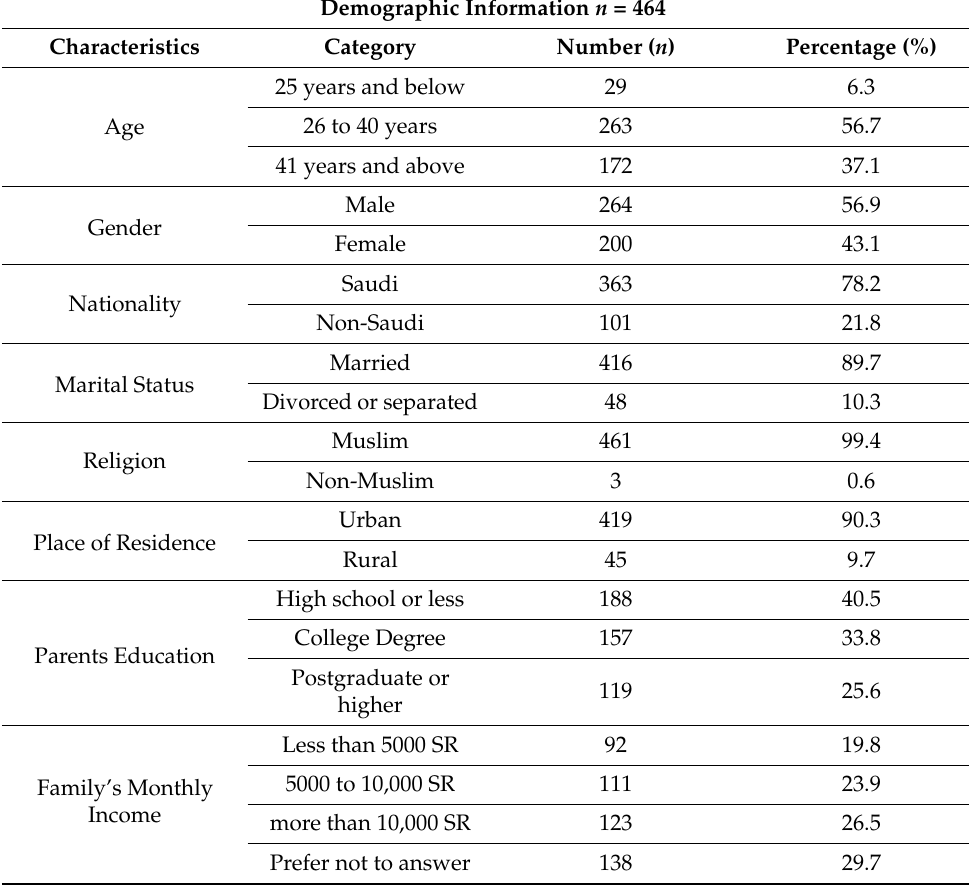
Table 1. Demographic details of the study